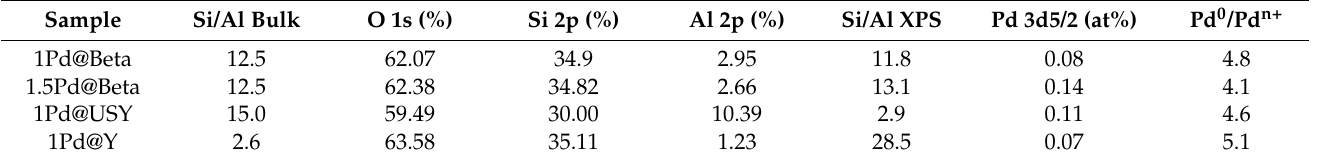
Table 2 compiles the atomic composition determined from the deconvolution normal- ized by taking the atomic sensitivity factors [37]. Table 2. The main elements and the atomic composition for each